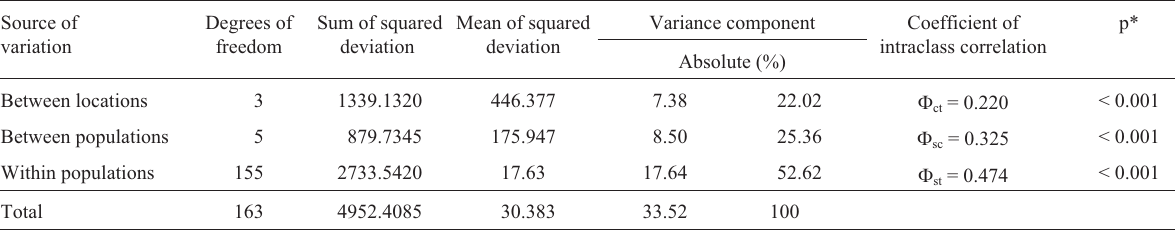
Table 3 - Analysis of Molecular Variance (AMOVA) of Rhodiola crenulata based on 184 inter-simple sequence repeat (ISSR) markers. Source of